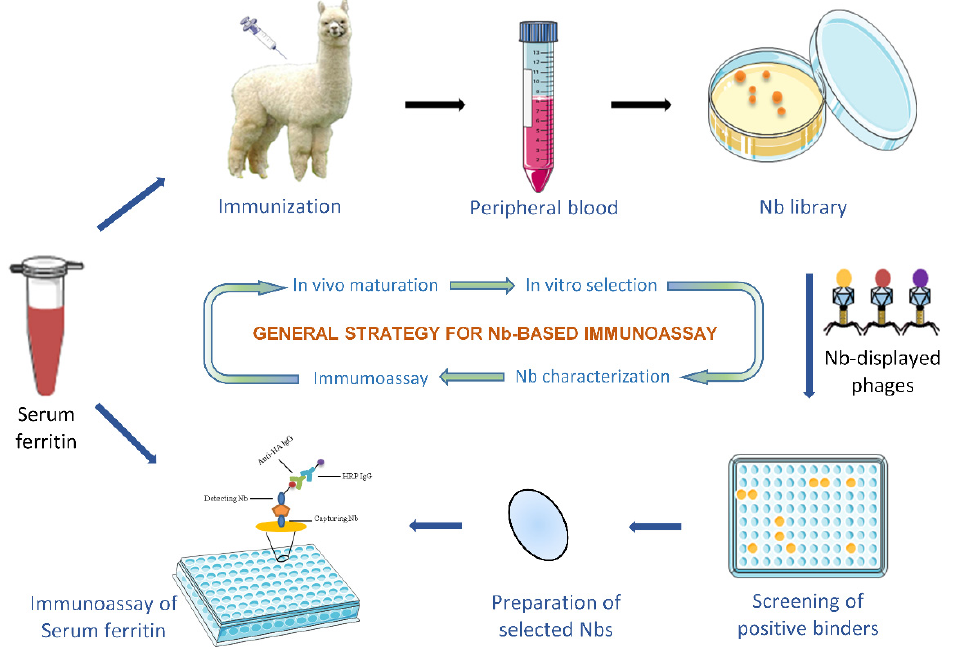
Figure 1. Schematic illustration of SF-specific Nb preparation and development of an immunoassay.